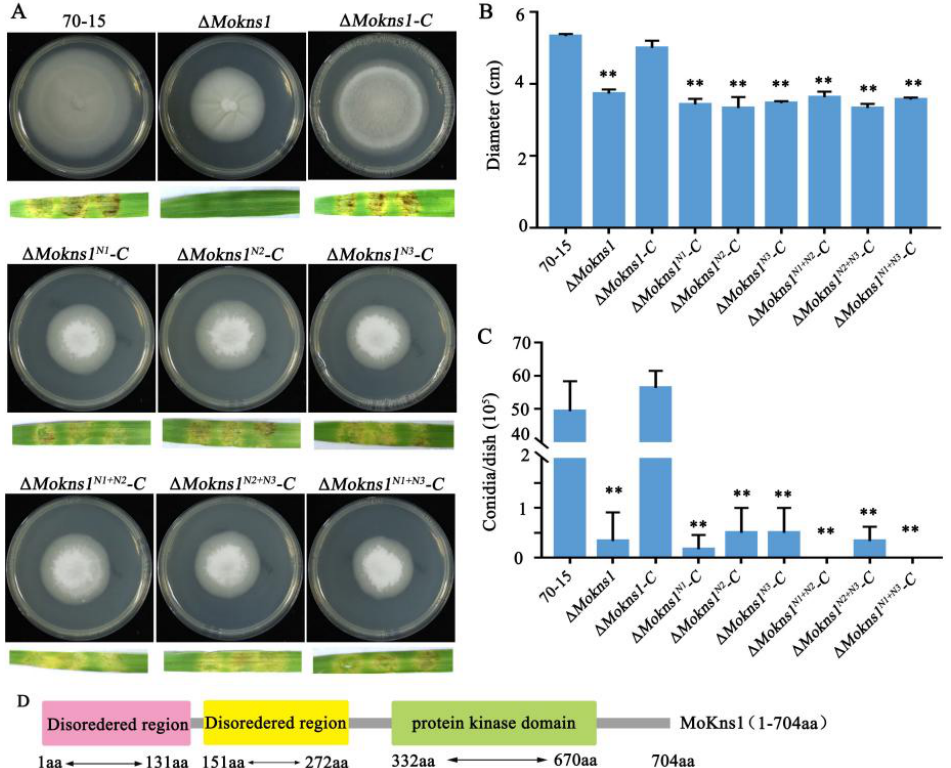
Figure 2. MoKns1 is important for growth, conidiation and pathogenicity. ( A ). The wild-type 70 − 15 strain, the ∆ Mokns1 mutant and the ∆ Mokns1 N1 –C , ∆ Mokns1 N2 –C , ∆ Mokns1 N3 –C , ∆ Mokns1 N1+N2 –C , ∆ Mokns1 N2+N3 –C , ∆ Mokns1 N1+N3 –C , ∆ Mokns1–C complemented strains were grown on CM medium for 9 days. ( B ). Statistical analysis of the diameters of hyphae from the WT, the ∆ Mokns1 mutant and the ∆ Mokns1 N1 –C , ∆ Mokns1 N2 –C , ∆ Mokns1 N3 –C , ∆ Mokns1 N1+N2 –C , ∆ Mokns1 N2+N3 –C , ∆ Mokns1 N1+N3 –C , ∆ Mokns1–C complemented strains on CM (Ducan’ test, ** p < 0.01). ( C ). Statistical analysis of conidia production (Ducan’ test, ** p < 0.01). ( D ). Map of MoKns1 with three